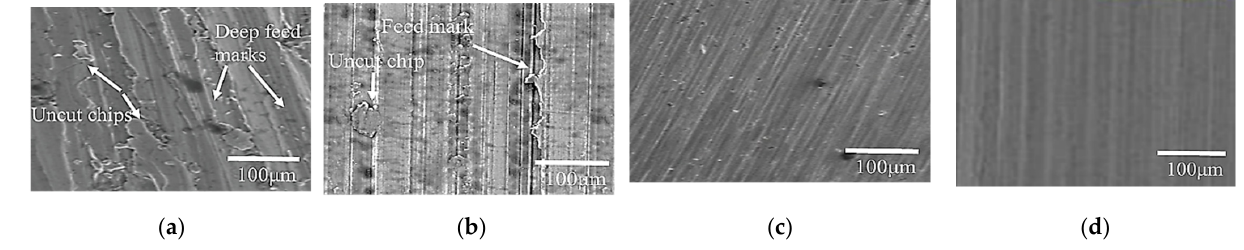
Figure 7. SEM images of machined surface at ( a ) s = 900 rpm, f = 360 mm/min, d = 0.6 mm, w =12 mm, c = 0 mL/h (dry condition), ( b ) s = 900 rpm, f = 360 mm/min, d = 0.6 mm, w =12 mm, c = 100 mL/h, ( c ) s = 1500 rpm, f = 320 mm/min, d = 0.2 mm, w = 4 mm, c = dry condition, ( d ) s = 1500 rpm, f = 320 mm/min, d = 0.2 mm, w = 4 mm, c = 100 mL/h.